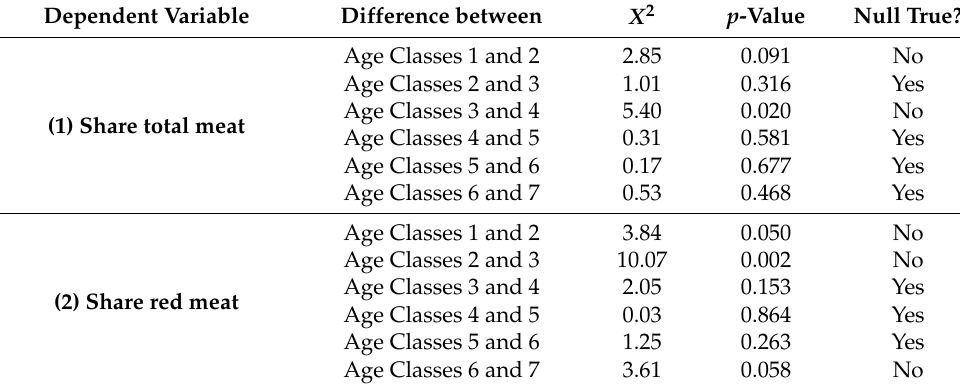
Table A3. Results of the Wald test for the gender